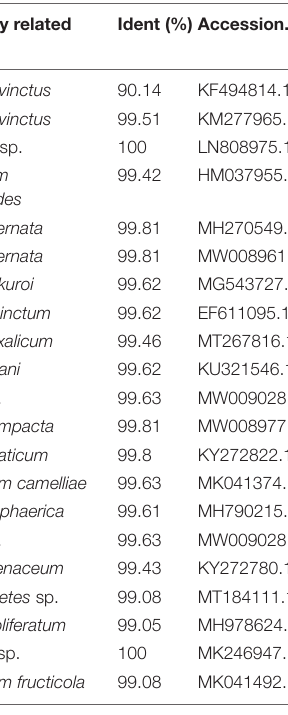
TABLE 2 | The homologous strain of endophyte fungi from